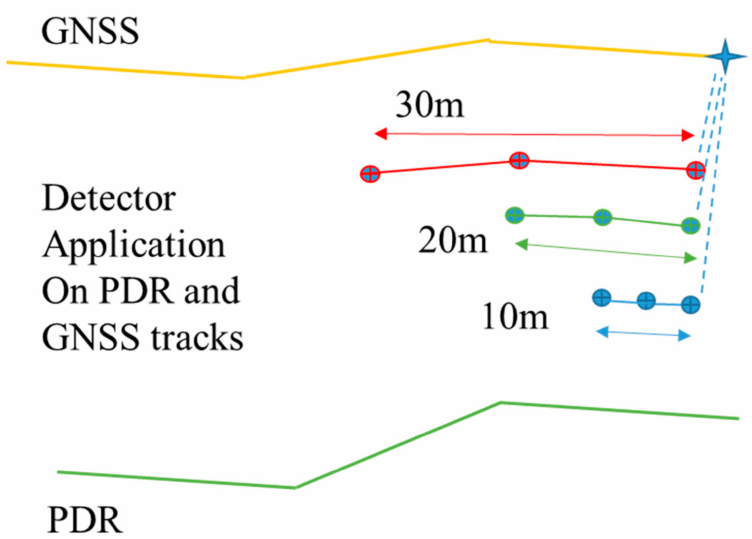
Figure 6. The three detectors are applied so that the first points are at the current